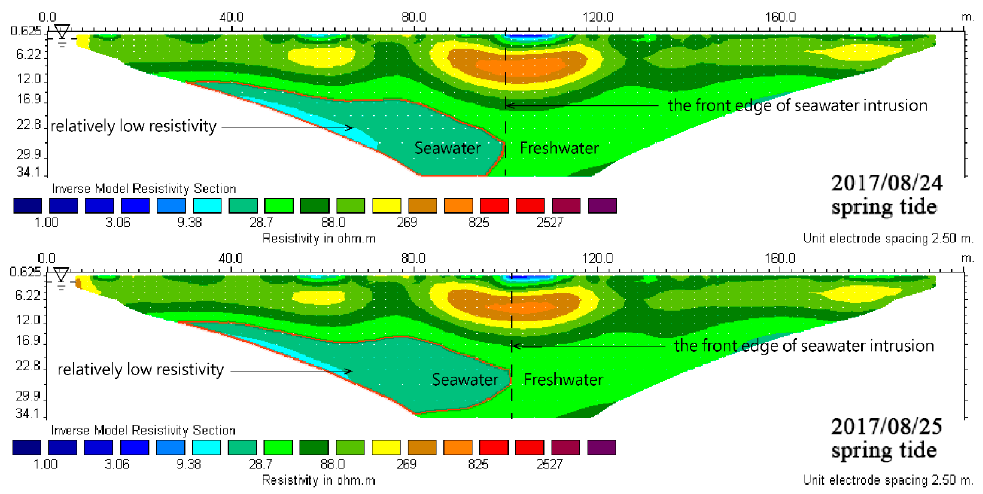
Figure 7. Ground resistivity profile of measuring line L1 from 9 August 2017 to 25 August 2017.